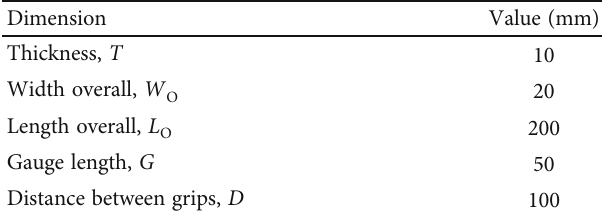
Figure 4: Glass fi ber-reinforced PET matrix with window glass fi ller composites. Table 2: Rectangular-shaped specimen